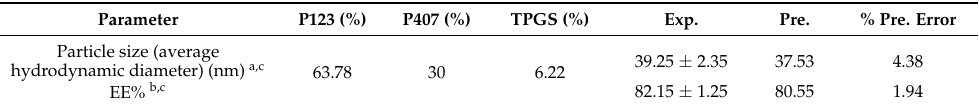
The experimental and predicted (A) particle size and (B) EE% of the optimized olanzapine PMs.